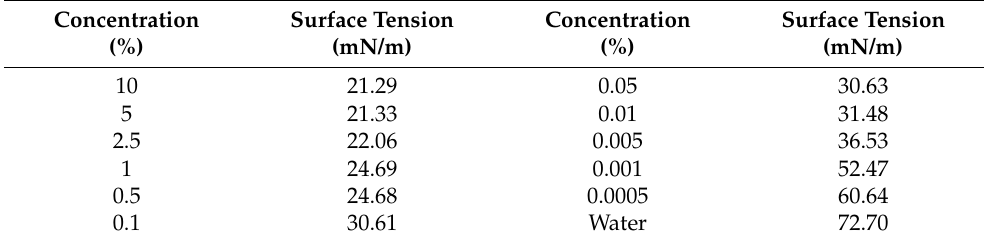
Table 2. The roughness factors for different leaf